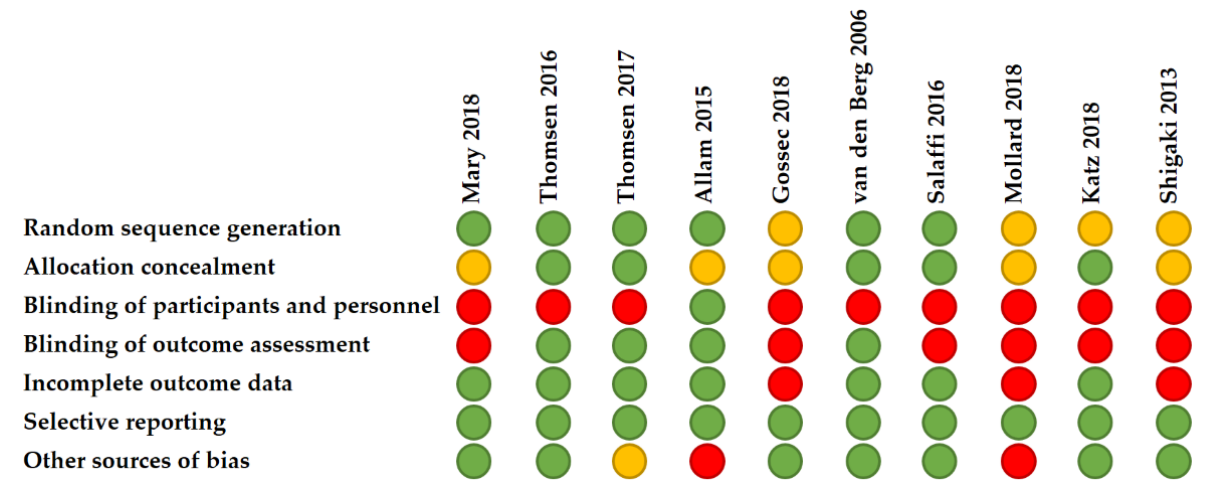
Figure 2. Assessment of risk of bias with the Cochrane Collaboration’s tool. Green=low risk of bias, red=high risk of bias, and orange=unclear risk of